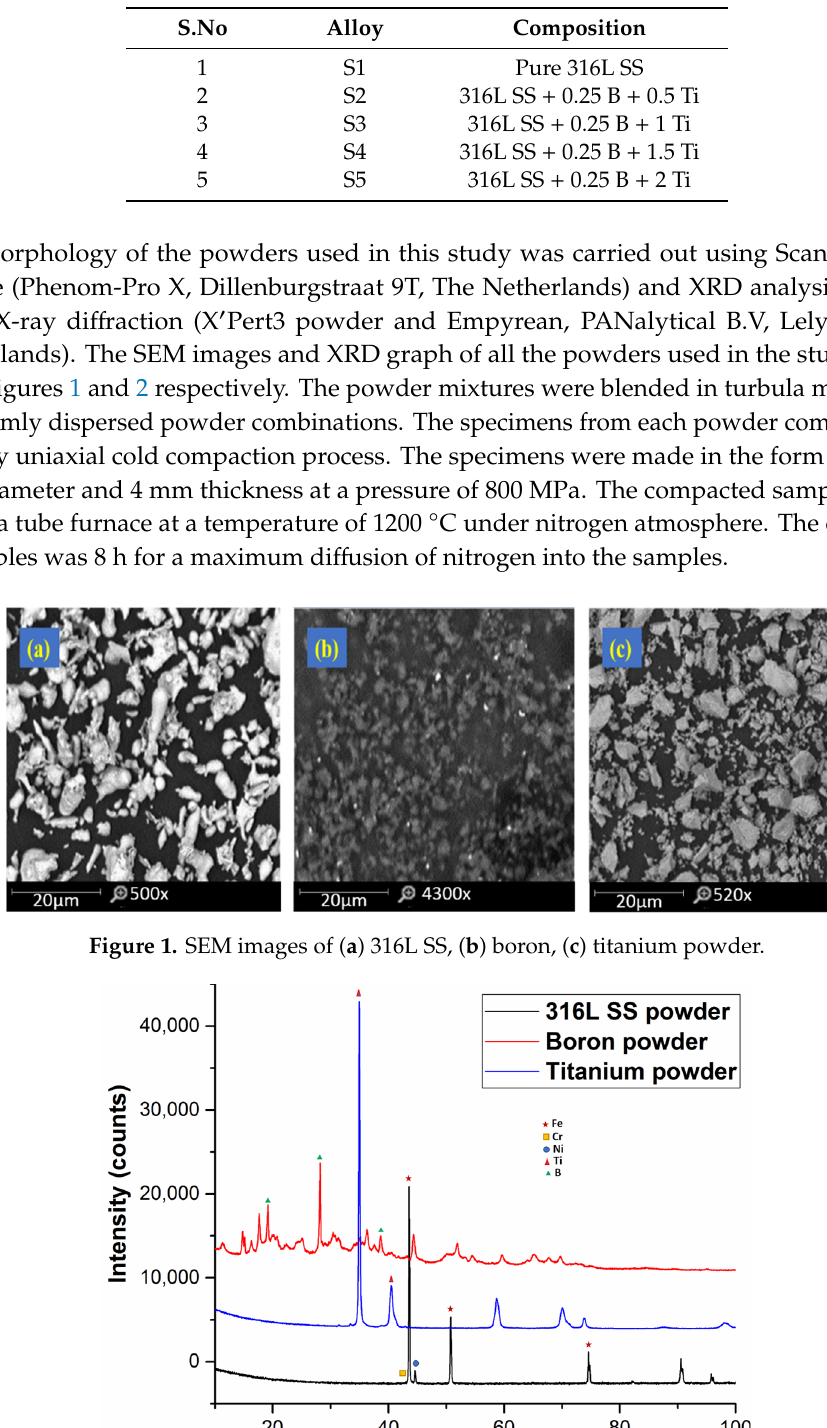
Table 2. Composition of the alloy systems produced.